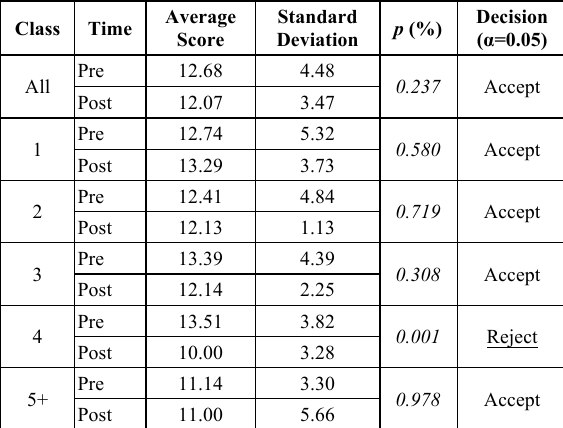
Table 6. Results of Perceived Choice versus Class